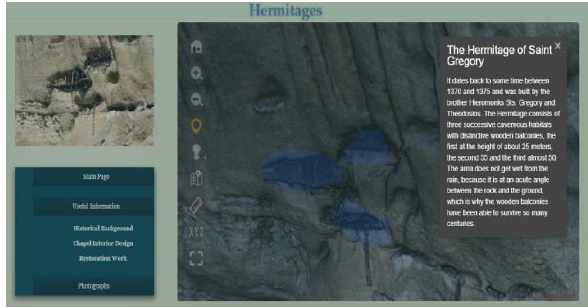
Figure 3. By selecting the highlighted spot, the view direction is rotated automatically to face the hermitage of Saint Gregory (Meteora) and the user can obtain information about the historical